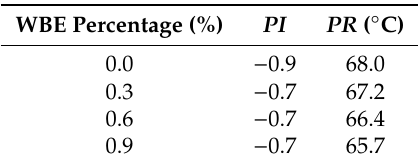
Table 8. Calculated penetration index (PI) and temperature plasticity range (PR) of 35 / 50 asphalt binders with variable amounts of